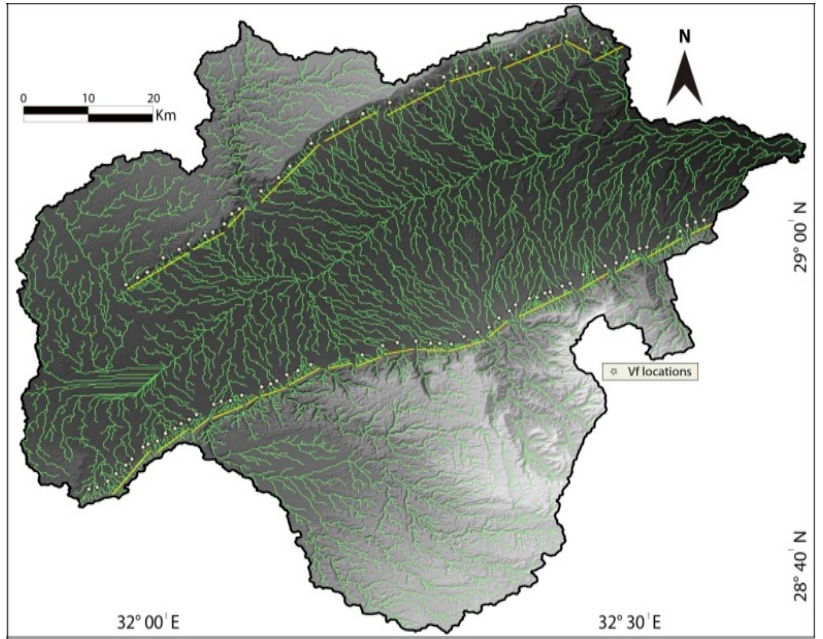
Figure 8. Location of the V f index along the stream crossing Northern and Southern Galala Plateaus.